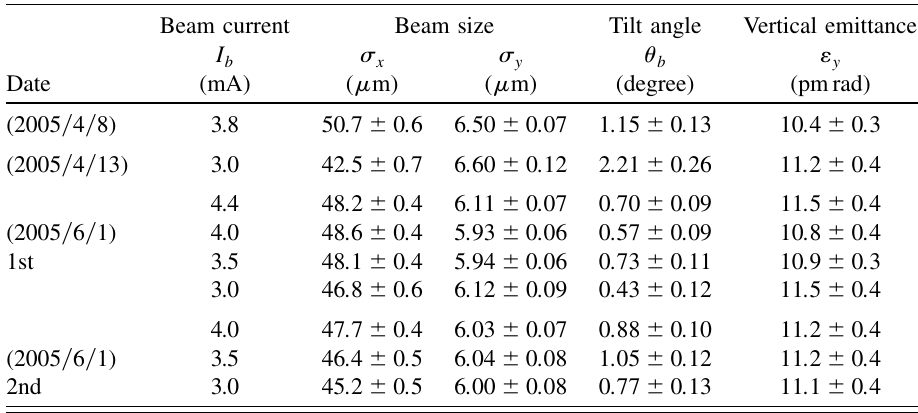
TABLE V. Summary of the measured beam sizes, the tilt angles, and vertical emittances by the FZP monitor. A skew correction was carefully carried out.